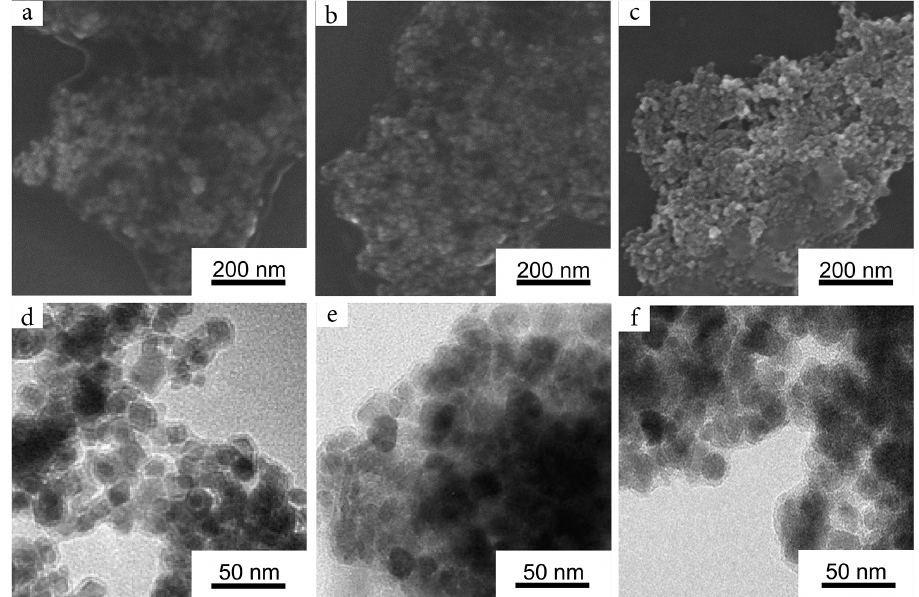
Figure 5. SEM and TEM images of GlyDop@Ferria ( a , d ), GlyDop@NitMP ( b , e ), and GlyDop@CitMP ( c , f ),